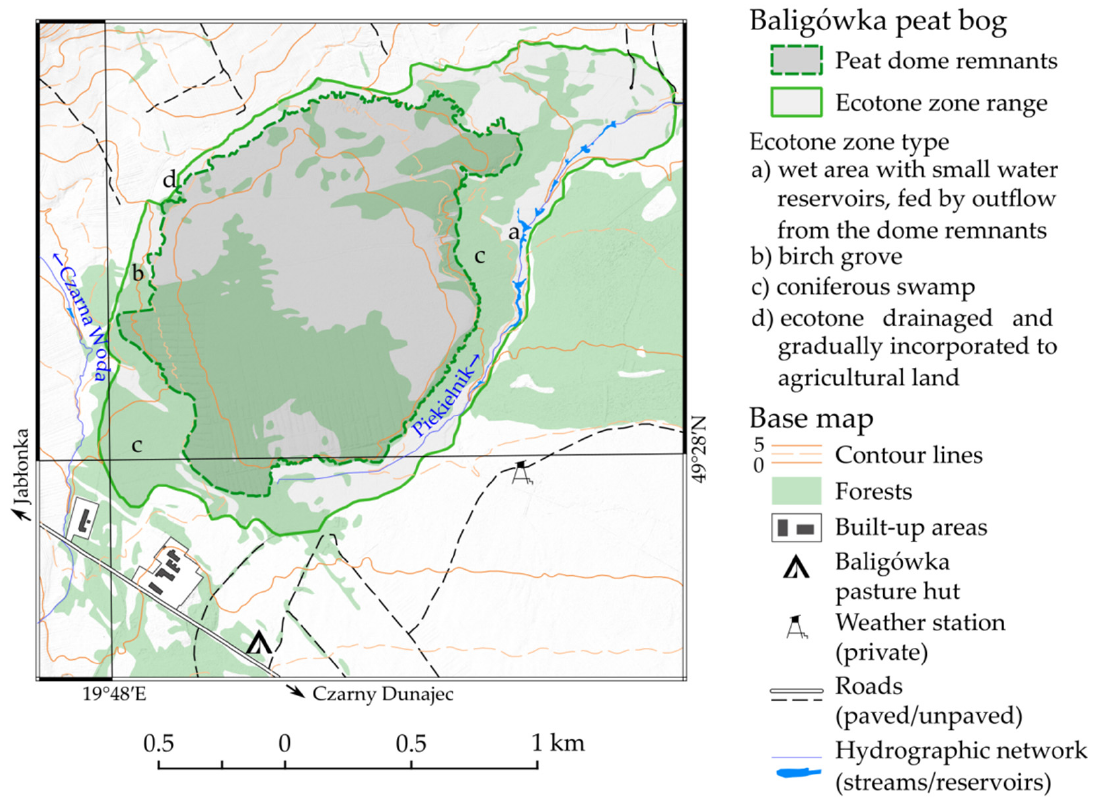
Figure 2. Map of the Baligówka peat bog.